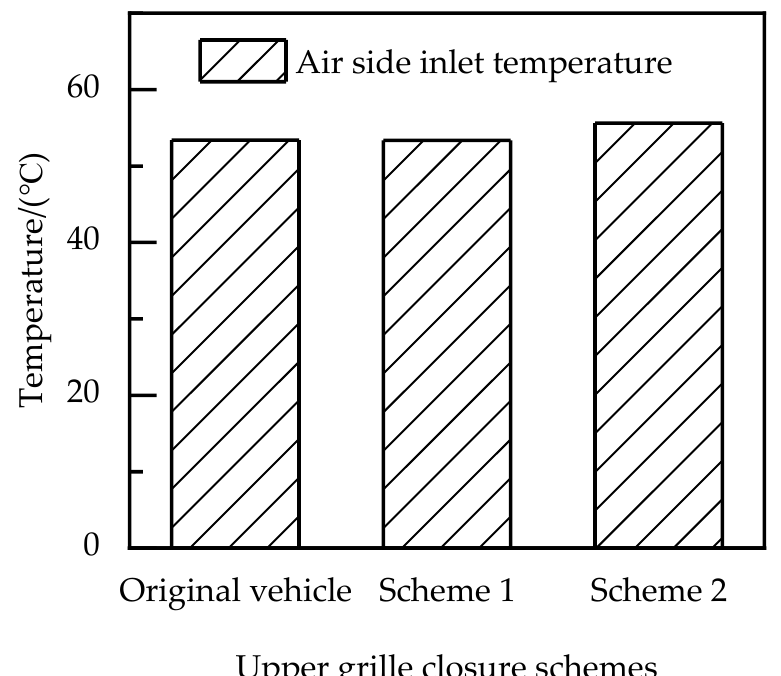
Figure 13. Comparisons of the radiator intake air temperature under different schemes.